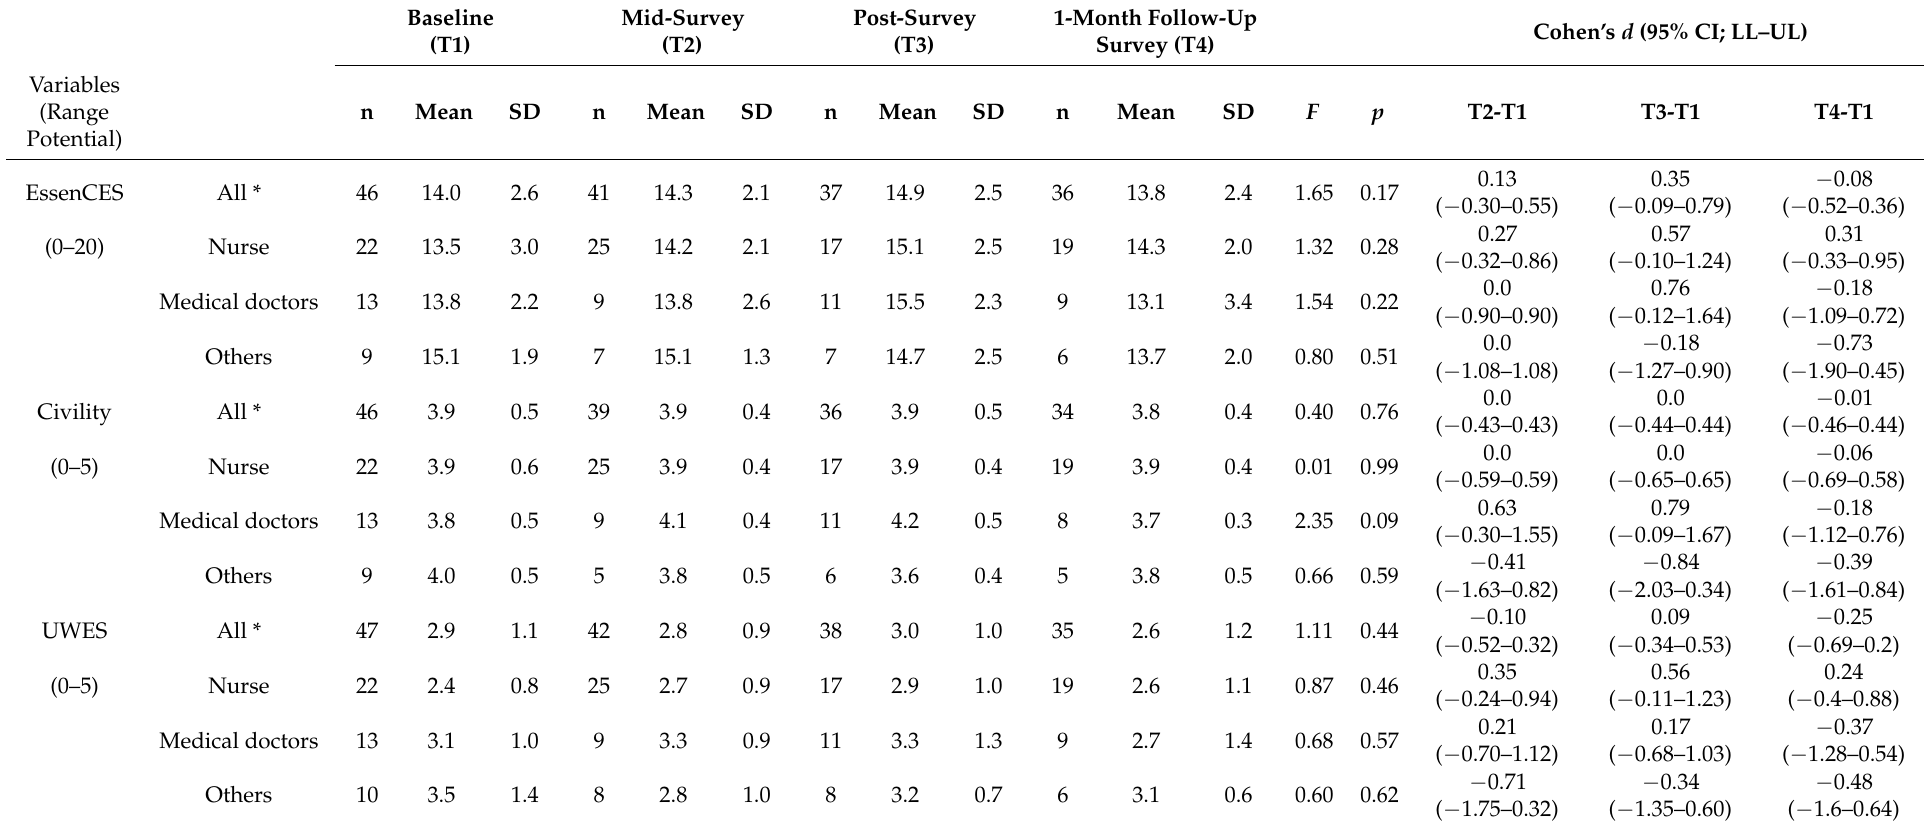
Table 2. Scores on three outcome variables and results analysis of variance by